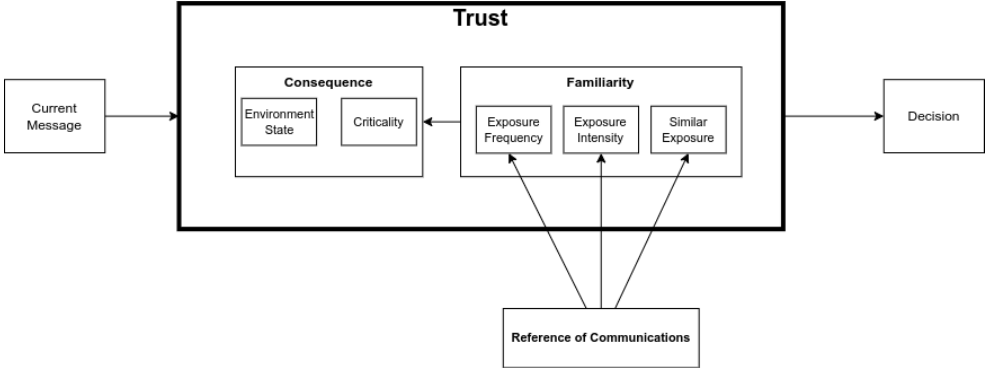
Figure 5. Proposed trust model for